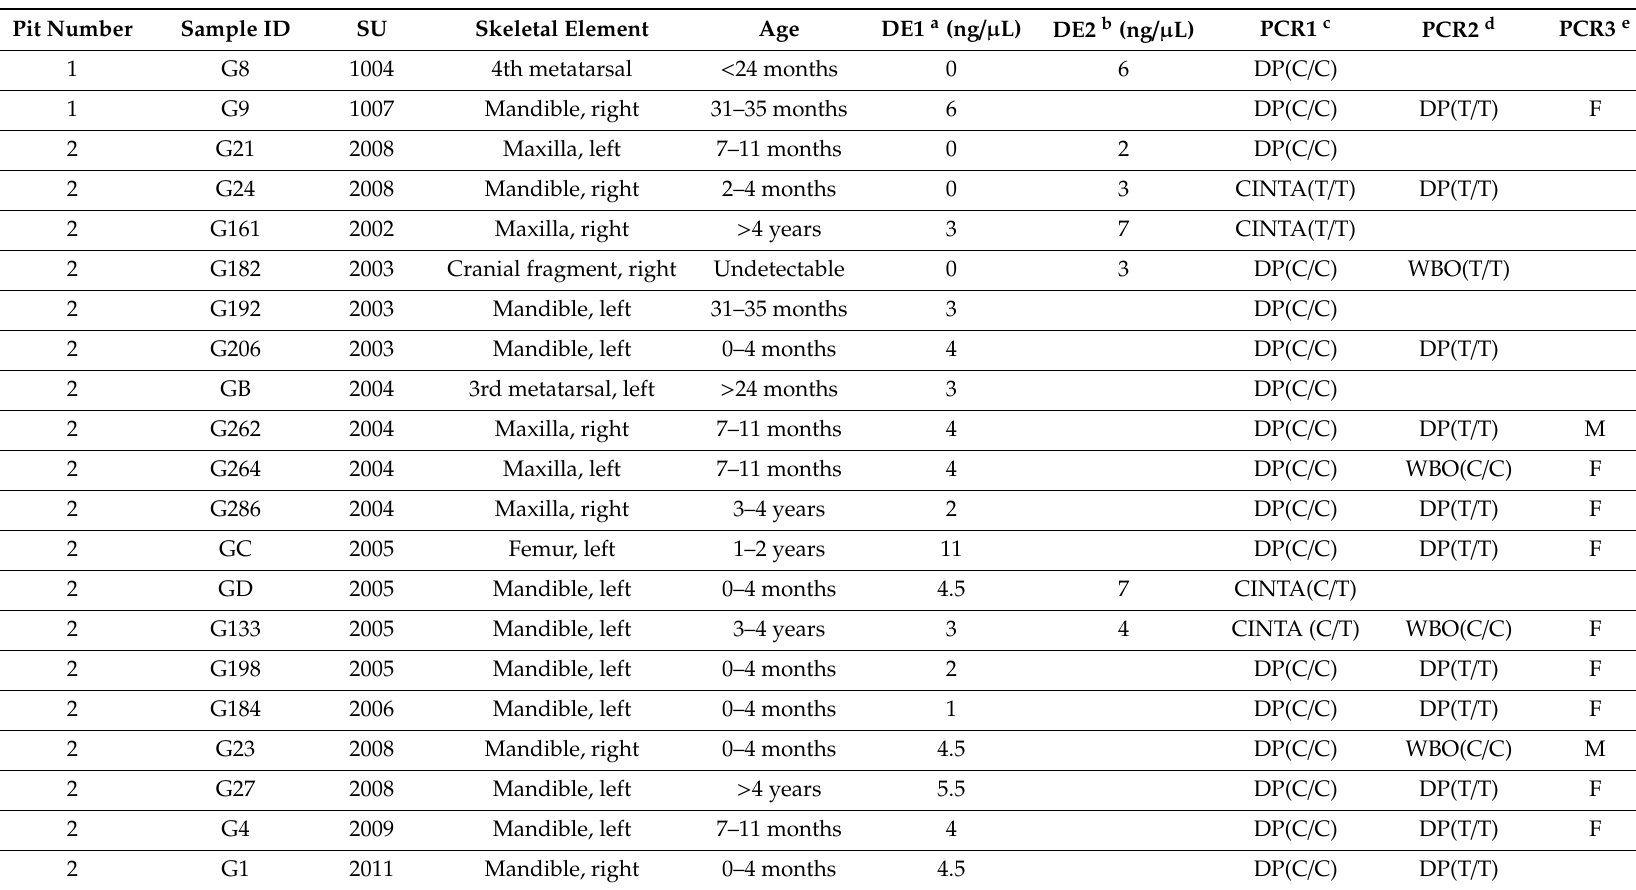
Table 2. Number of individuals, pit number, stratigraphic units (SU), skeletal elements, age (based on [35]), DNA quantification with two di ff erent extraction protocol (ng / µ L), and PCR results (DP: Domestic Pig; WBO: Wild BOar) are reported for the 21 samples identified in Table